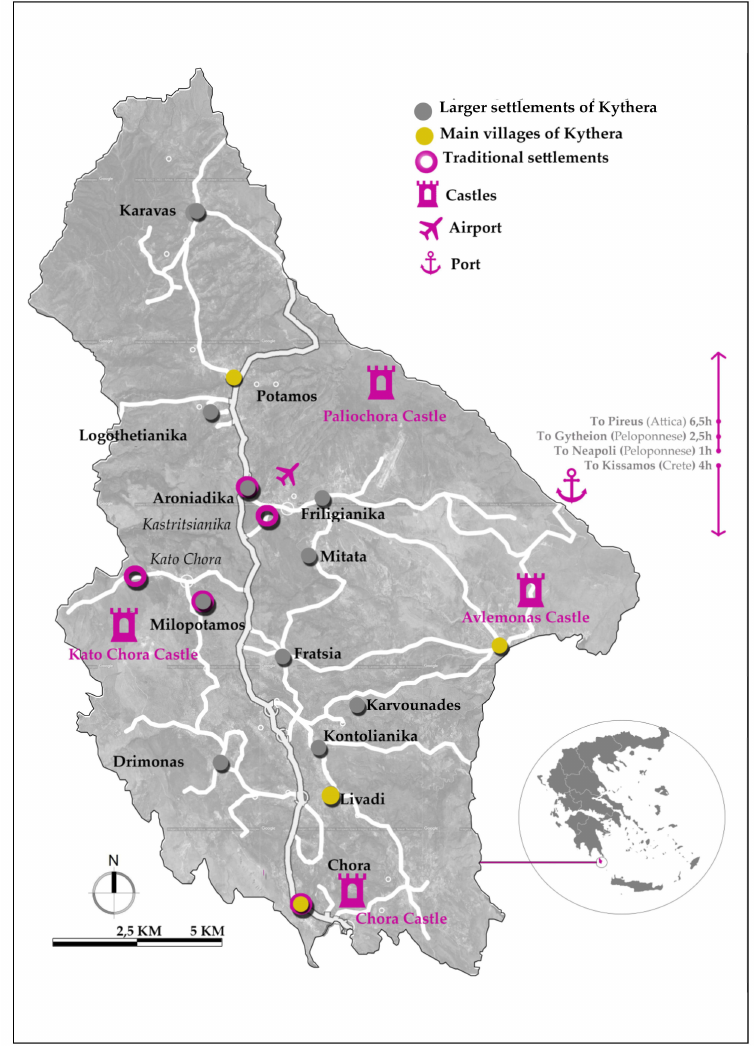
Figure 2. The map of Kythera.